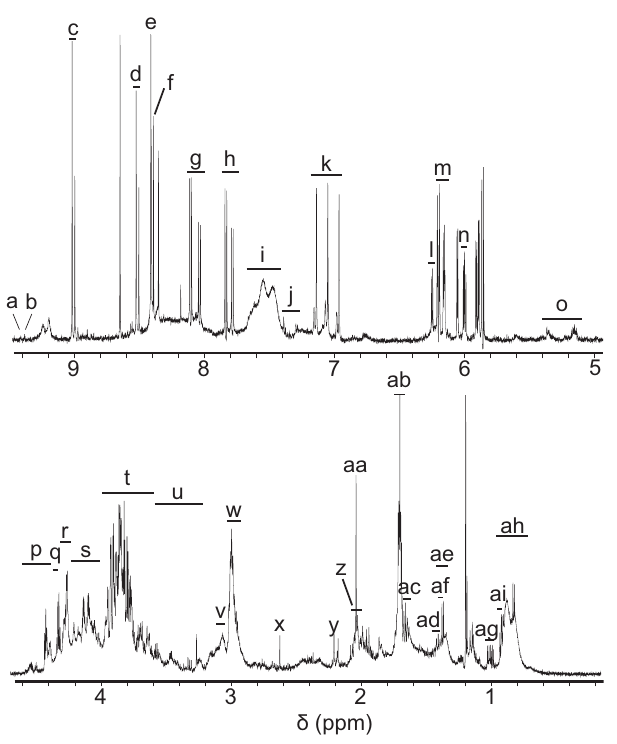
Fig 2. One dimensional 600 MHz 1 H NMR of an extractof E . coli not stressed by nano-TiO 2 and incubated under room light. Resonance assignmentsare given in S2 Table. Code number: a- NADP+; b- NAD+; c&n- 5’GMP; d- 5’-AXP; e- 5’,3’-cAMP; f- 5’,3’-cAMP; g- 5’-CMP or 5’-dCMP; h- 5’-UMP or UDP- glucose;i- NH3+ moieties, mainly putrescine,also cadaverine and ornithine;j- phenylalanine; k- ammonium; l- 5’-AXP & 5’,3’-cAMP; m- 5’-CMP and 5’-dCMP; o&t- carbohydrates & amino acids; p- nucleoside derivatives, carbohydrates and amino acids; q- mainly 5’-GMP; r- mainly lactate, also nucleoside